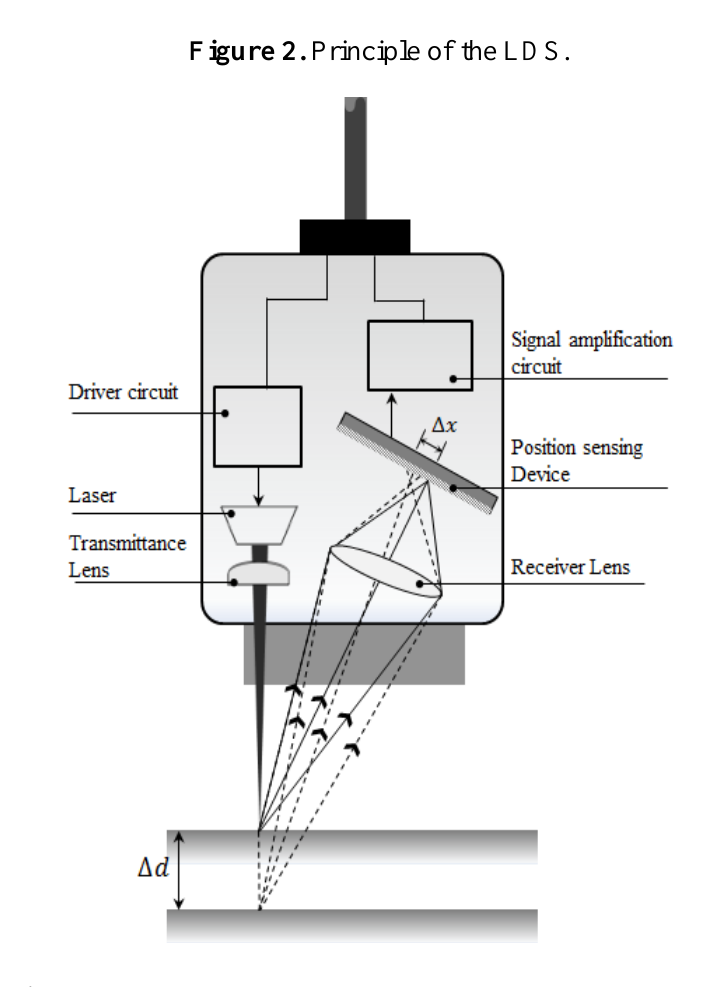
Figure 2. Principle of the